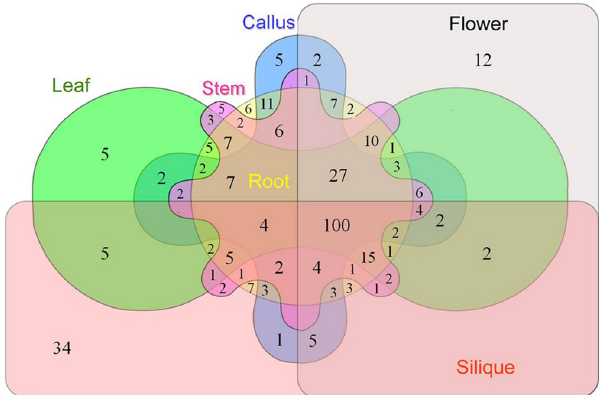
Fig 5. Venn diagram depicting the expression distribution of positively selected genes among six Chinese cabbage tissues, including roots, stems, leaves, flowers, siliques and callus.